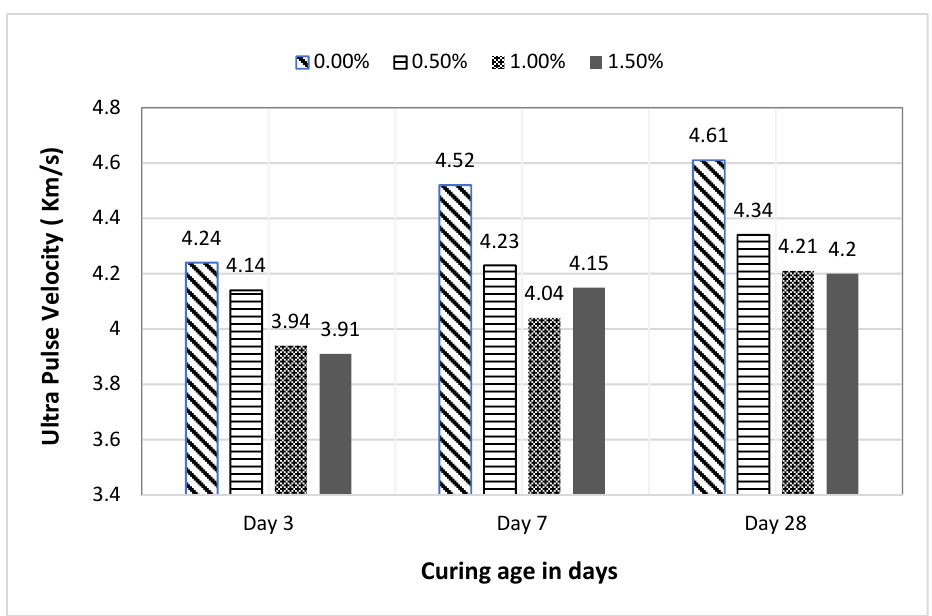
Buildings 2022 , 12 , x FOR PEER REVIEW Figure 5. The effect of adding PA fibers on the UPV of concrete mixes at 3, 7, and 28 days of curing.